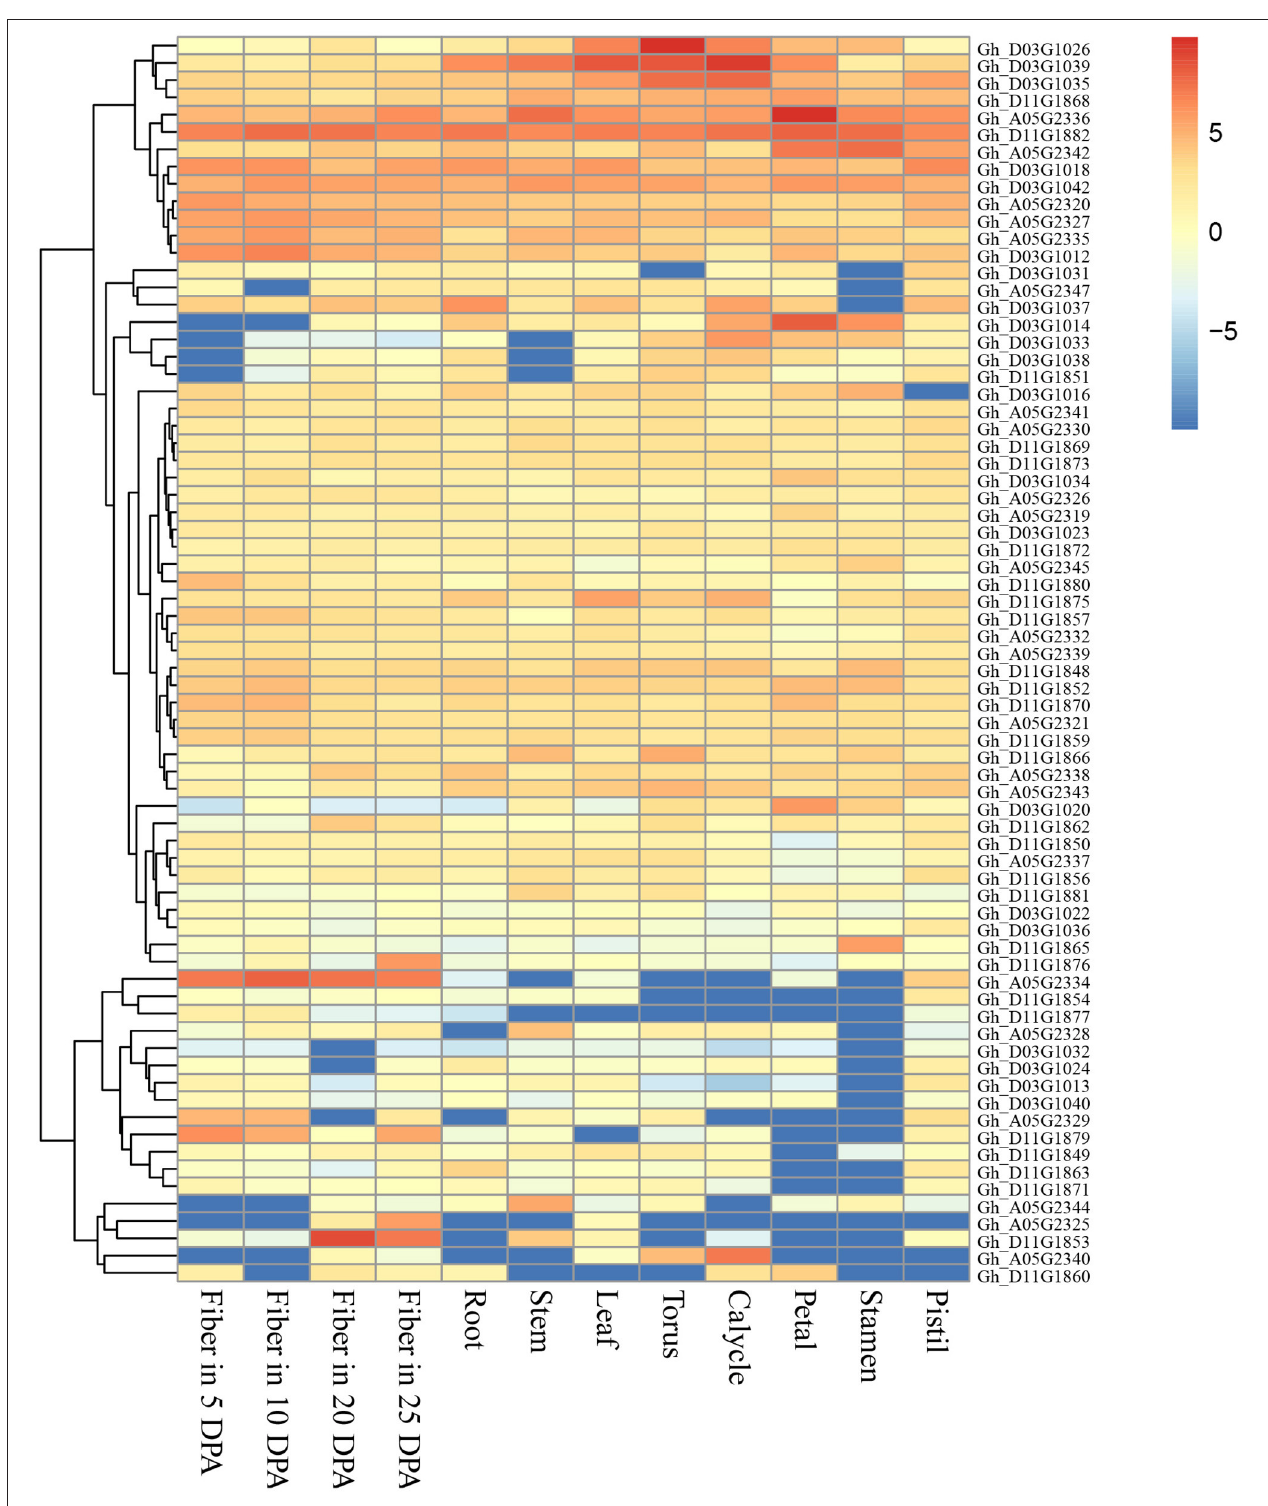
FIGURE 4 | Heat map of expression level of the 72 genes in 12 upland cotton tissues. The red indicates high expression, and the blue shows low expression.